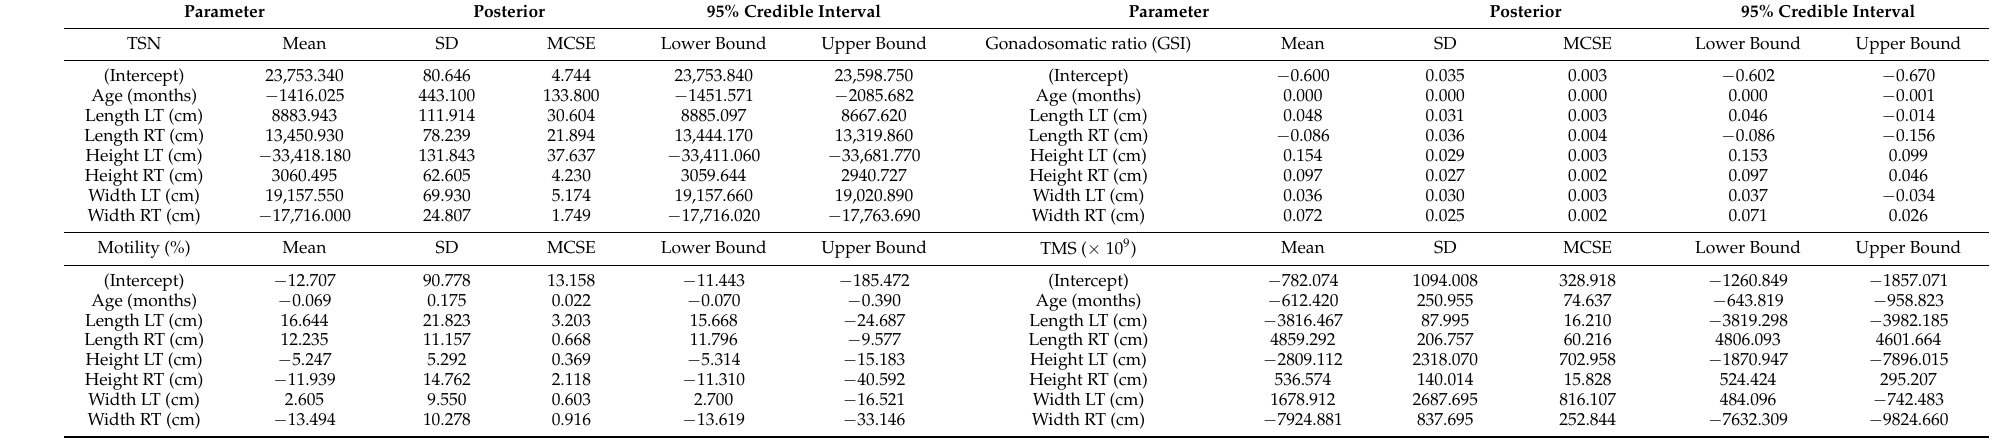
LT—left testicle; RT—right testicle. Table 6. Bayesian Estimates of Unstandardized Linear Regression Coefficients for predictive model 1 for TSN, gonadosomatic ratio (GSI) (%), motility (%), and TMS ( × 10 9 ) sperm output in Miranda donkey